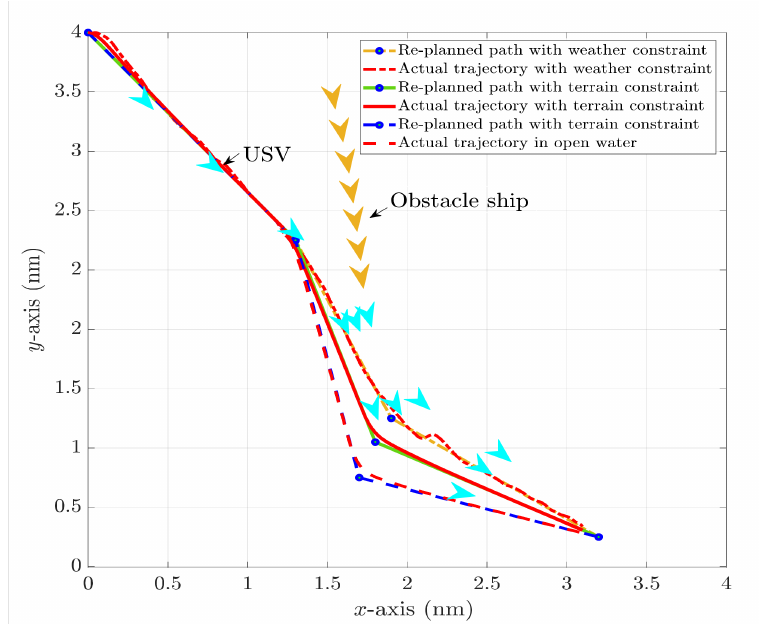
Figure 21. Collision avoidance paths and actual trajectories of USV under overtaking encounter situations with different constraints.